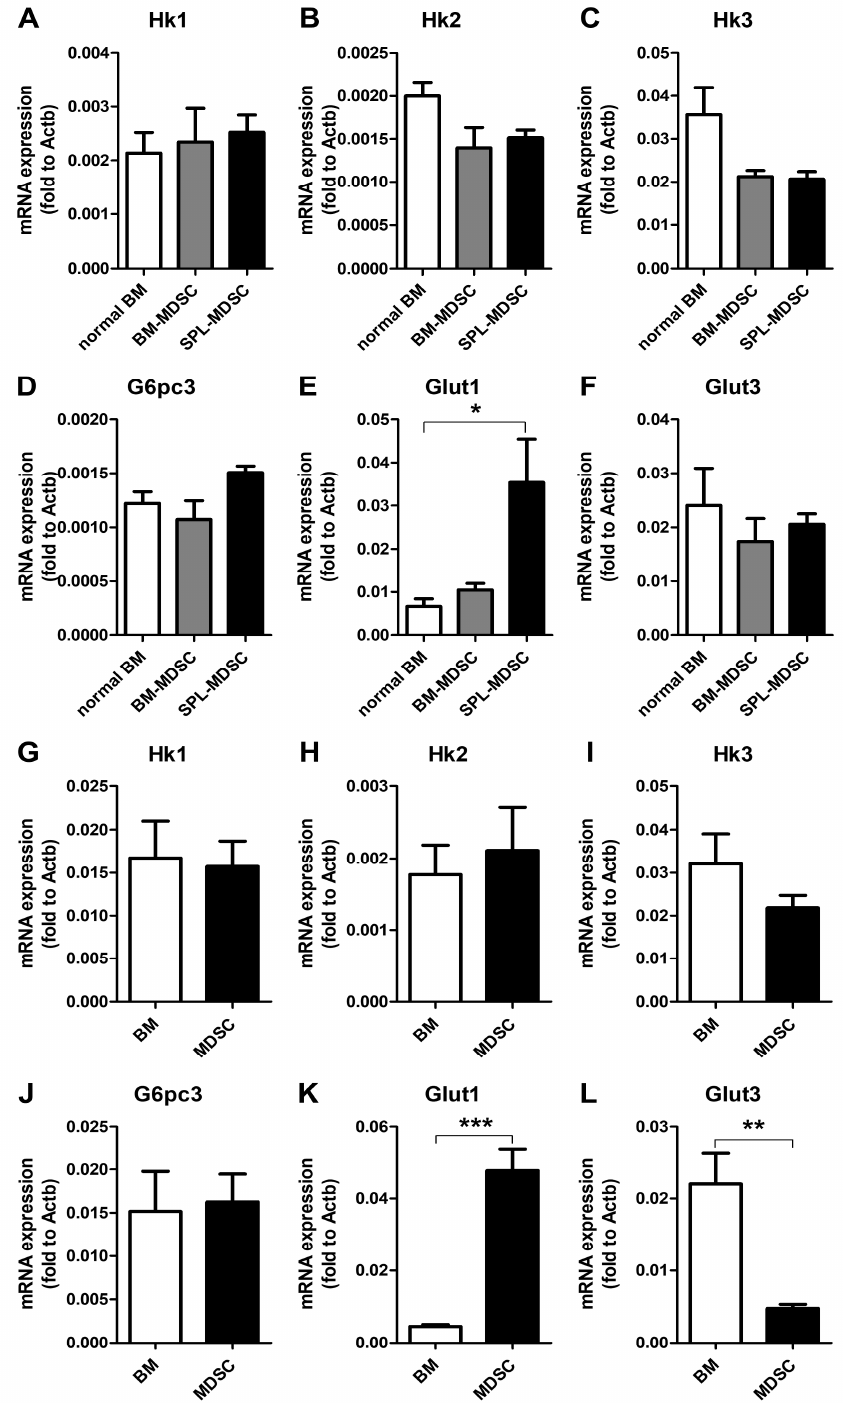
Figure 4. mRNA expression levels of genes related to glucose concentration in MDSCs. ( A – F ) Cells were harvested from normal or tumor-engrafted mice. ( G – L ) MDSCs were differentiated from mouse BM cells in vitro. The mRNA expression levels were measured by qRT-PCR and normalized by Actb . Data shown are expressed as mean ± SEM of three replicates with similar results. *, p < 0.05; **, p < 0.01; ***, p < 0.001. ( A – F ) The p values were obtained by a one-way ANOVA followed by Tukey’s post-hoc test. ( G – L ) The p values were obtained by Student’s t